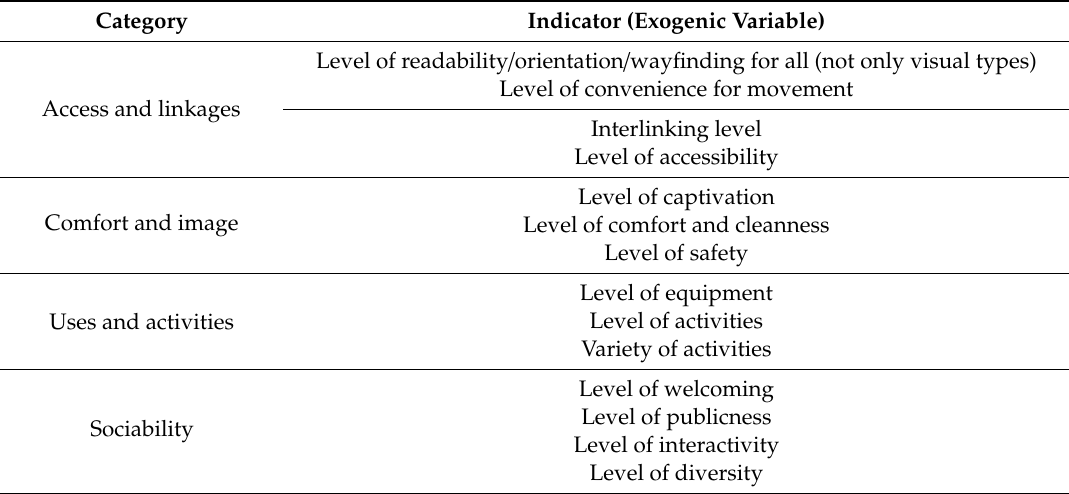
Table A1. The structure of POS Quality Index (QI).